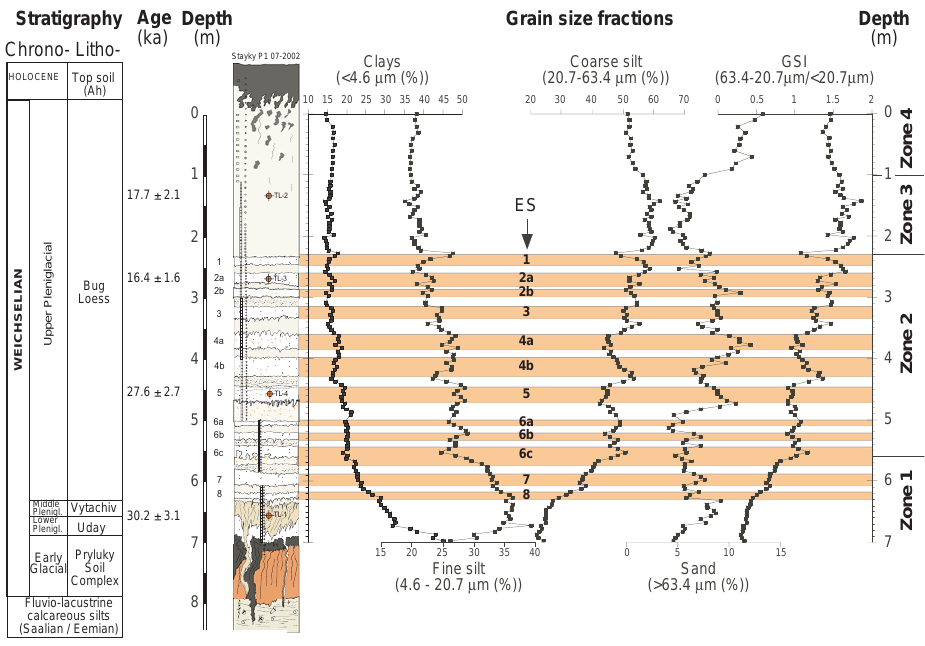
Fig. 4. Grain size variations in the Stayky loess sequence. Plots of the four identified size fractions (clay, fine silt, coarse silt, sand) and of the grain size index (GSI), defined as the ratio between coarse and fine material fractions.